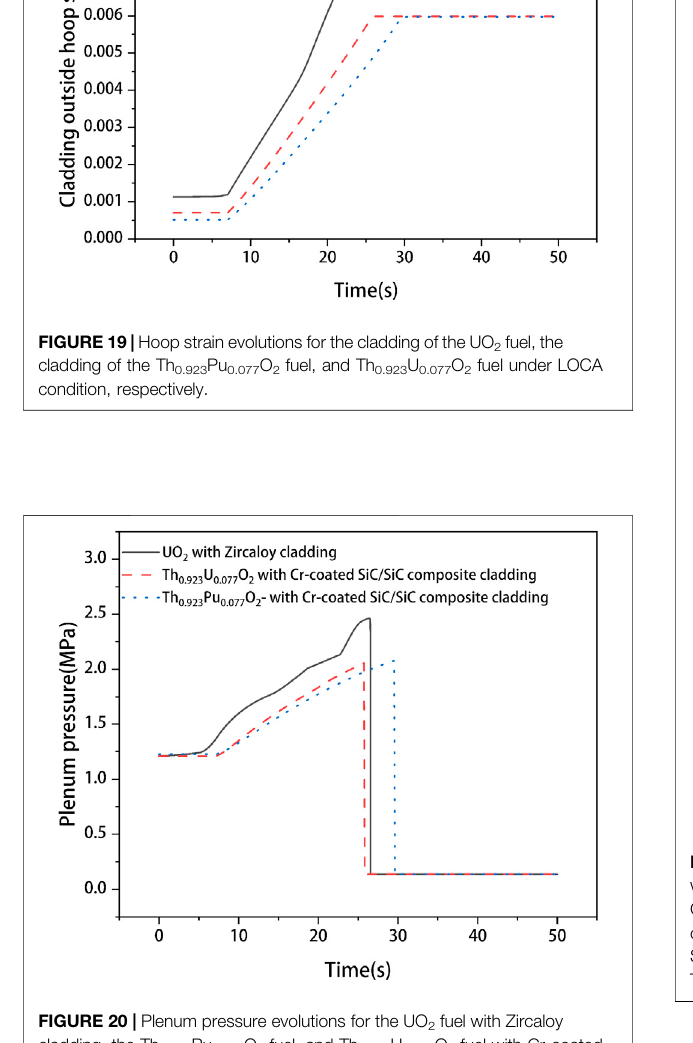
FIGURE 20 | Plenum pressure evolutions for the UO 2 fuel with Zircaloy cladding, the Th 0.923 Pu 0.077 O 2 fuel, and Th 0.923 U 0.077 O 2 fuel with Cr-coated SiC/SiC composite cladding under the LOCA condition, respectively.